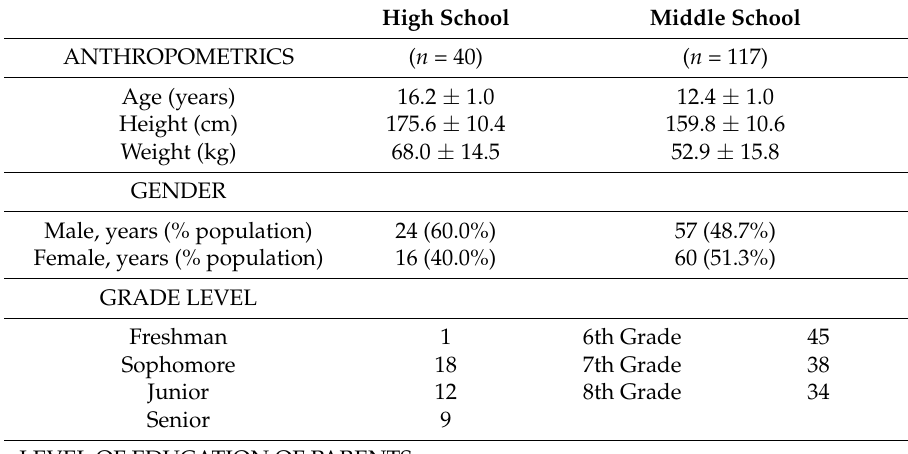
Table 1. Demographic data characteristics of active high school and middle school